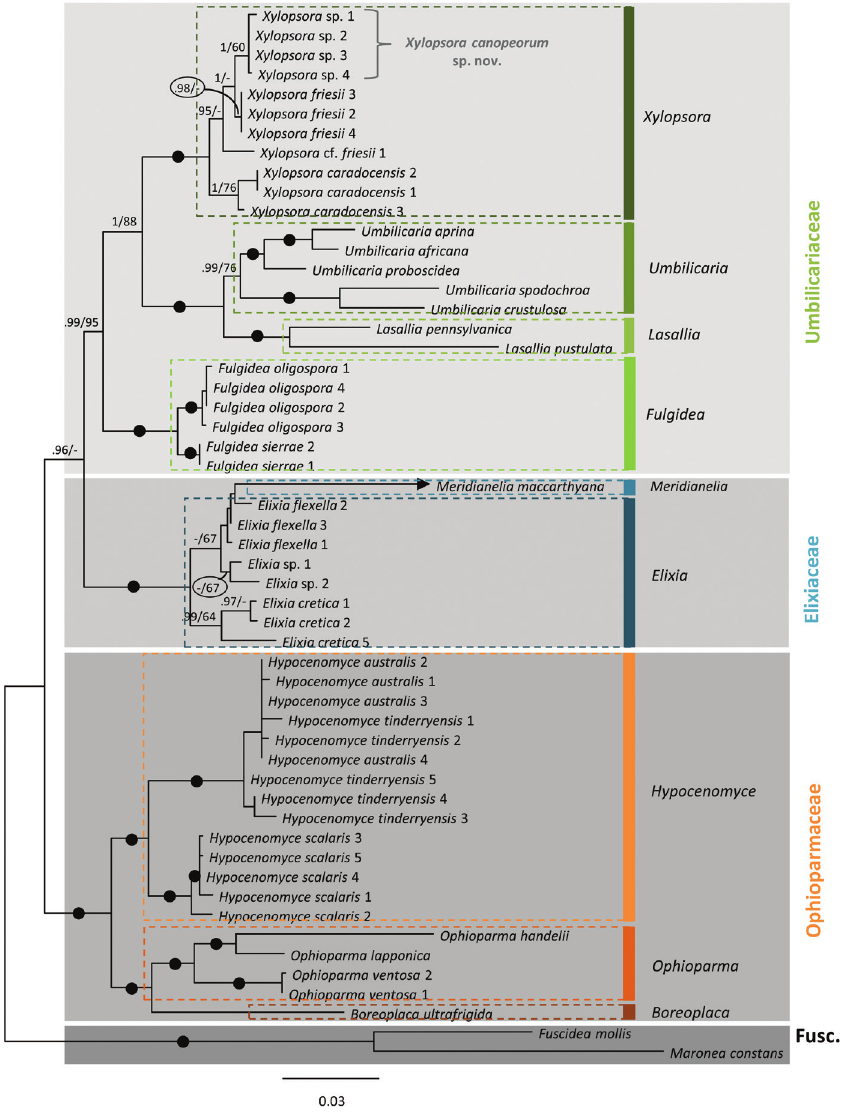
Figure 1. Hypothesis of the phylogenetic relationships and placement of the potentially undescribed species of Xylopsora based on DNA sequence data. The depicted topology is based on an automated alignment (MSAsate) of two nuclear (ITS and LSU) and one mitochondrial (SSU) ribosomal loci and is the “best tree” from a RAxML analysis using SATé-II. Clade support over certain values from Bayesian inference (posterior probability; PP) and parsimony jackknifing (JK) analyses are superimposed: PP >0.9 and JK>60% (PP/JK). Clades receiving maximum PP support (1.0) and at least 90% JK support are in- dicated with a black dot. Multiple accessions of the same taxon are numbered according to Table 1 (also corresponding to the numbering in Bendiksby & Timdal 2013). Family and genus circumscriptions are indicated. Abbreviation: Fusc. = Fuscideaceae. One accession in the tree ( Meridianelia maccarthyana ) ap- peared on a very long branch that is manually shortened (arrow tipped) to reduce the size of a broad